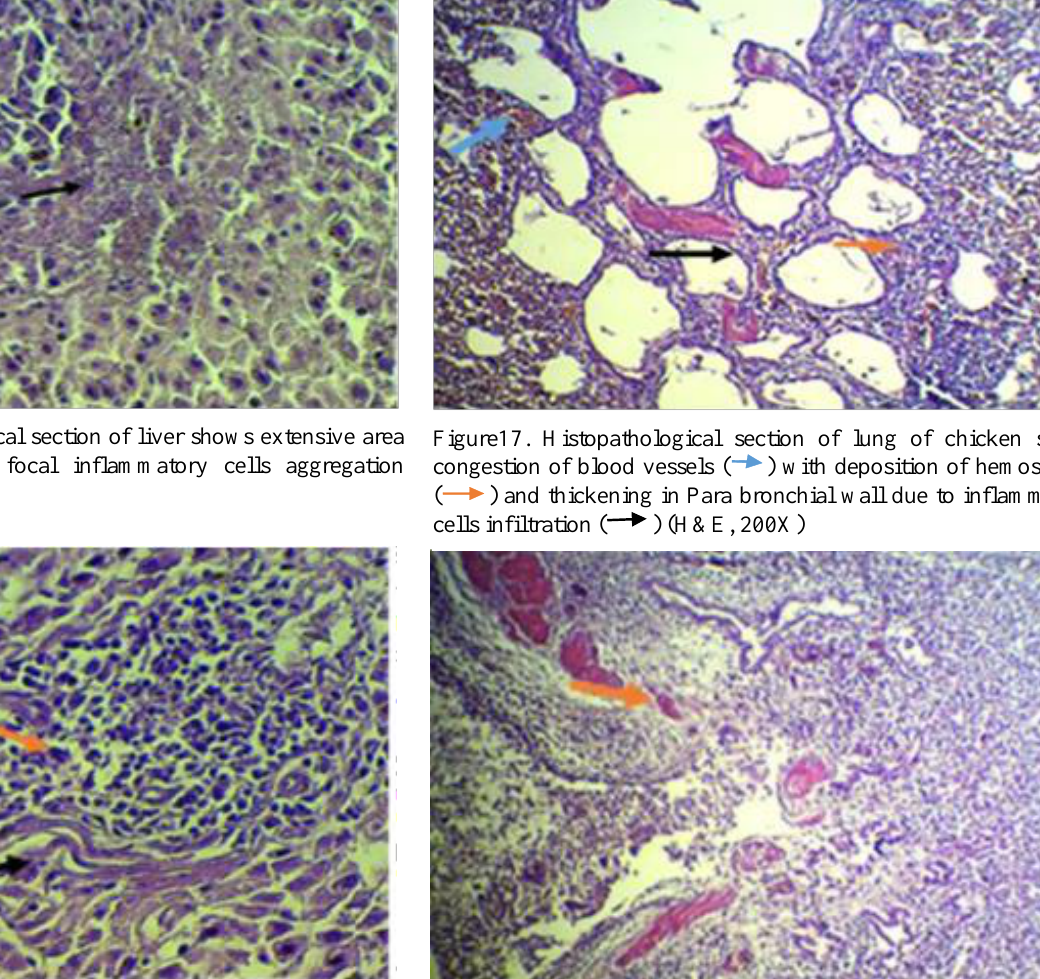
Figure18. Histopathological section of lung of chicken shows congestion of atrium with inflammatory cells infiltration ( ) (H&E,